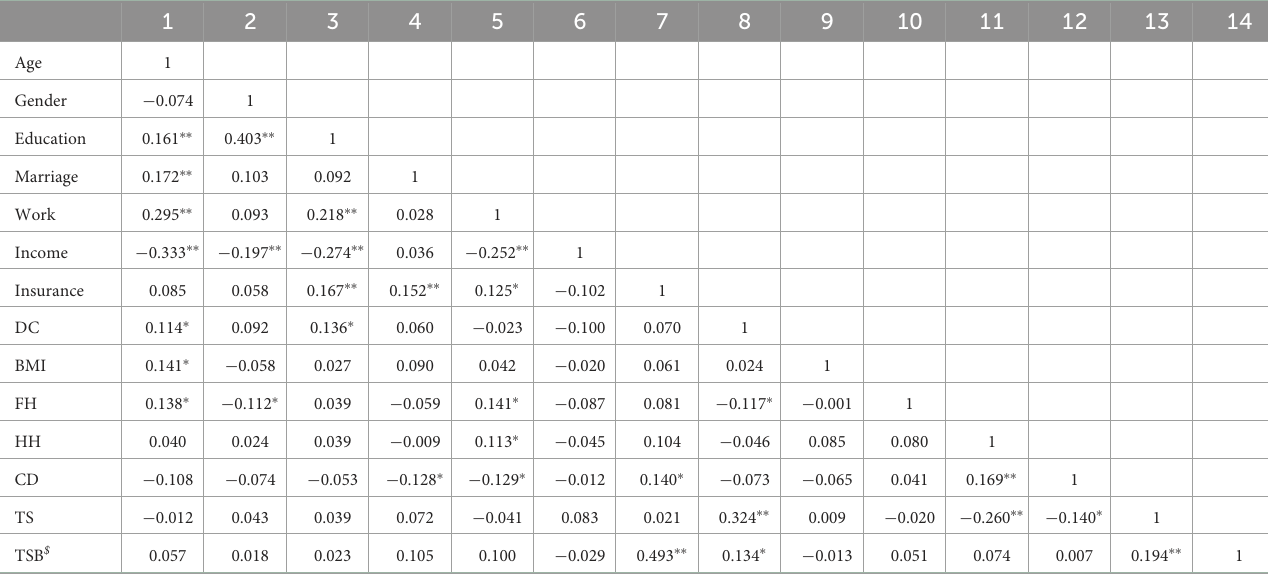
TABLE 4 A correlation matrix of